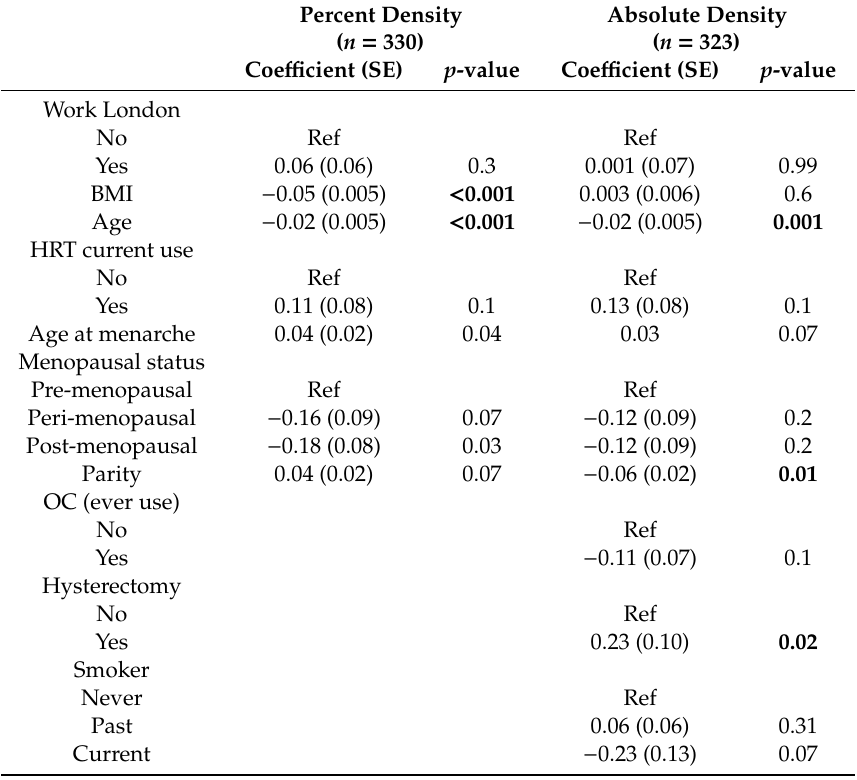
Table 3. Results of multiple regression analysis including those working in the urban setting (restricted to women currently working); only coe ffi cients for those variables included in the final model are shown. Percent Density Absolute Density ( n = 330) ( n = 323) Coe ffi cient (SE) p